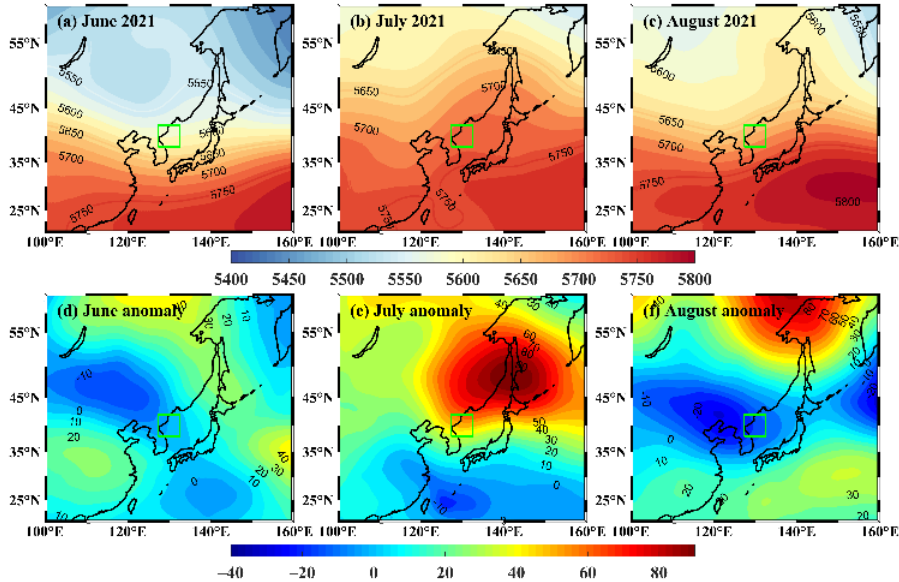
Figure 6. 500 hPa geopotential heights (units: gpm), ( a – c ) Blocking high from June to August 2021, ( d – f ) Geopotential height anomalies from June to August 2021, relative to the climatology (1982–2021). The green box is the study area.